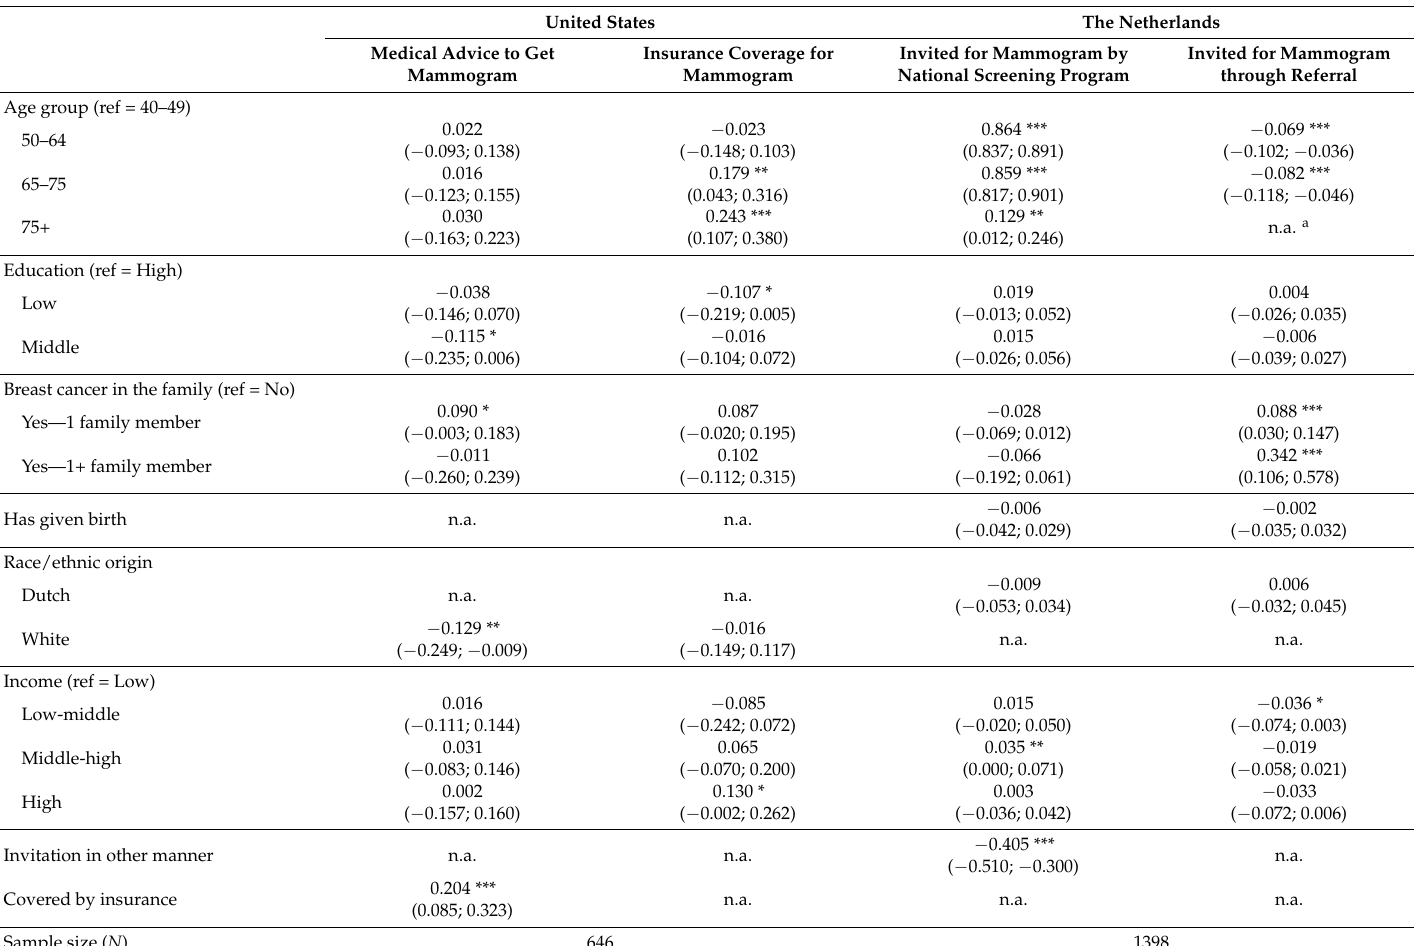
Table 4. Differences in probability of medical advice, insurance coverage and screening invitation for